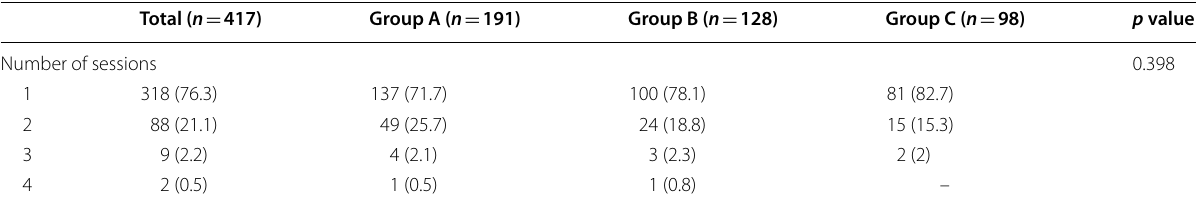
Table 3 Number of prone sessions required according to the duration of the first prone session